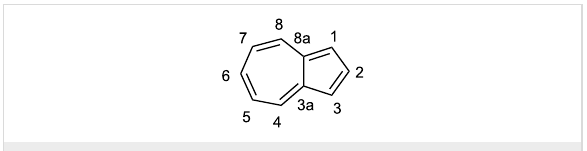
Figure 1: Numbering of